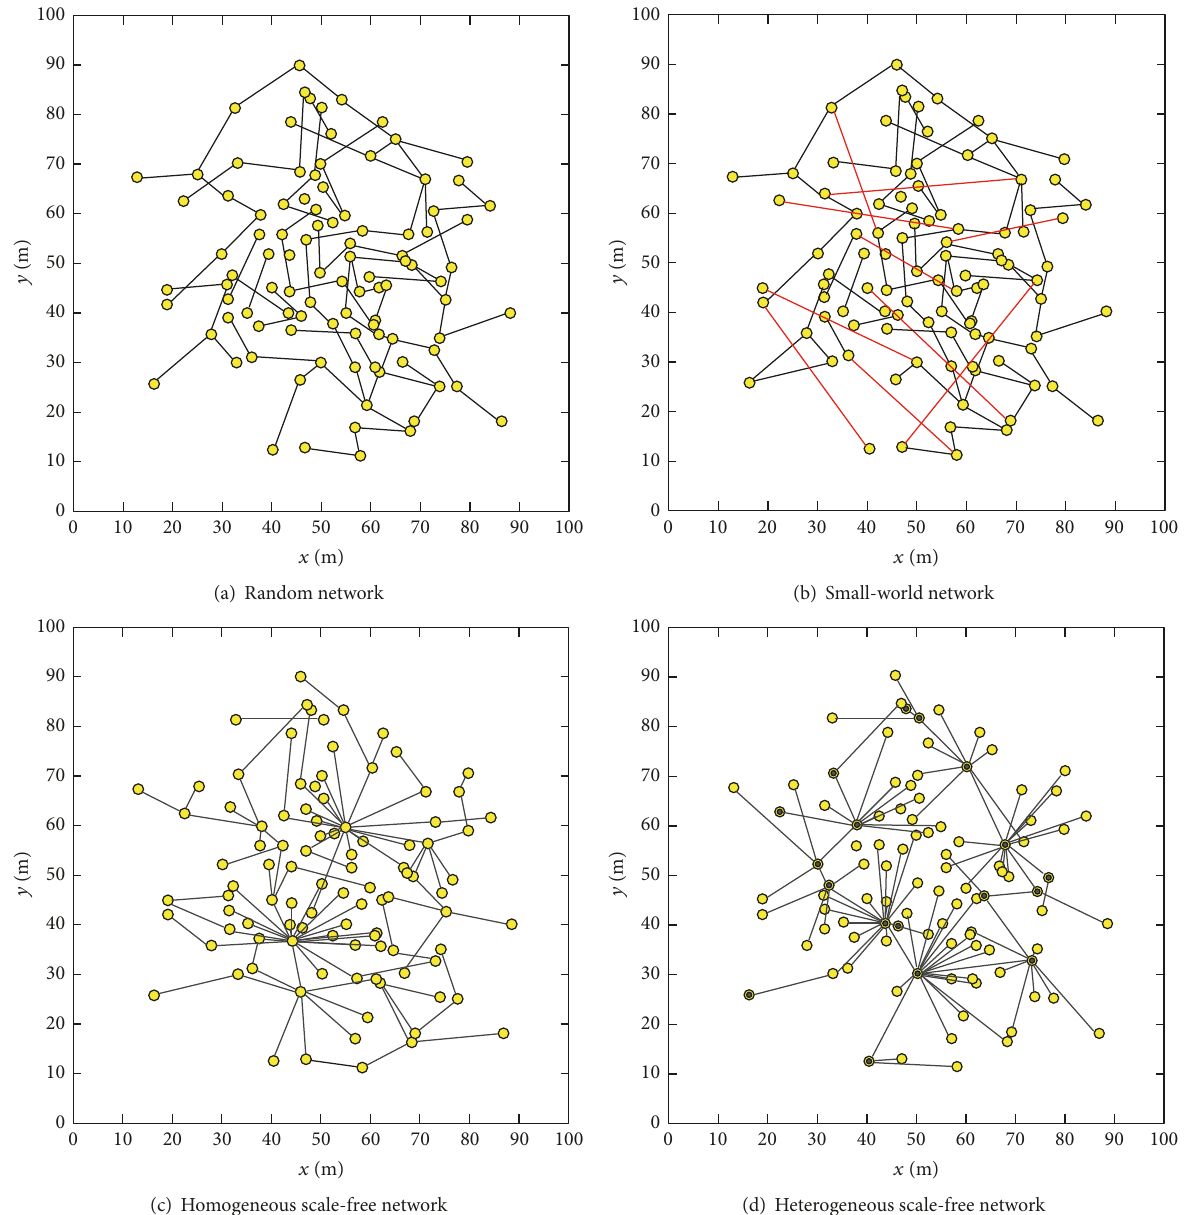
Figure 2: A sample of four topology construction